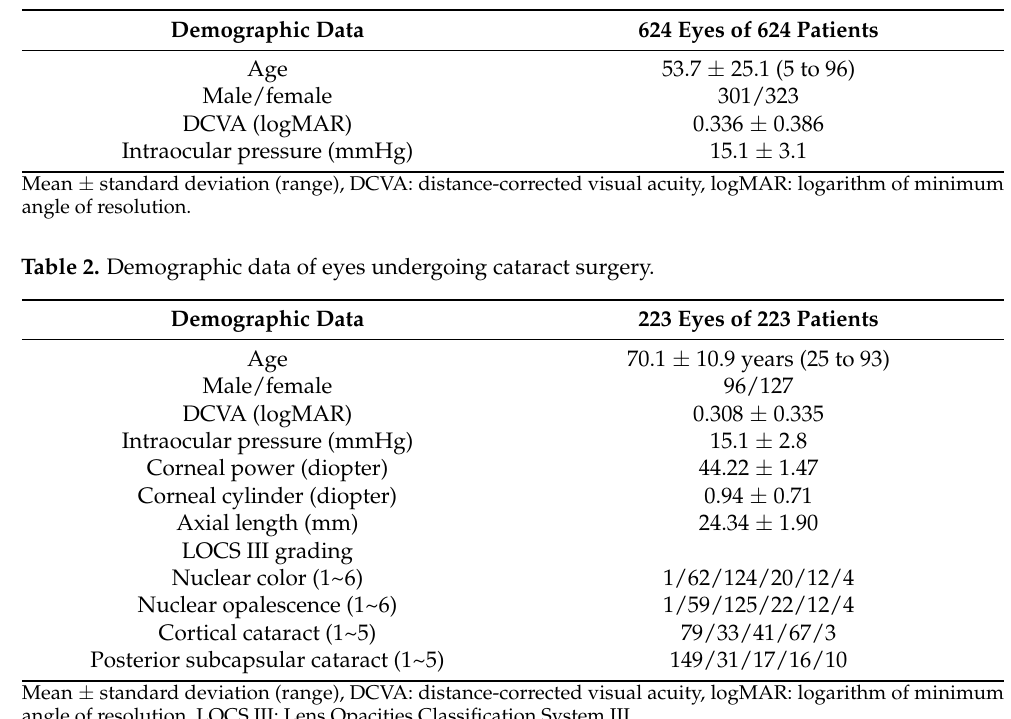
Table 1. Demographic data of the whole study population.